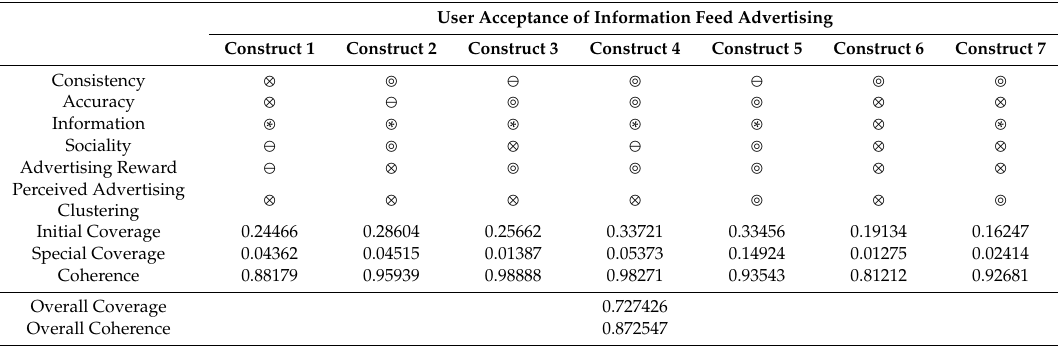
Table 7. Results of adequacy analysis for seven